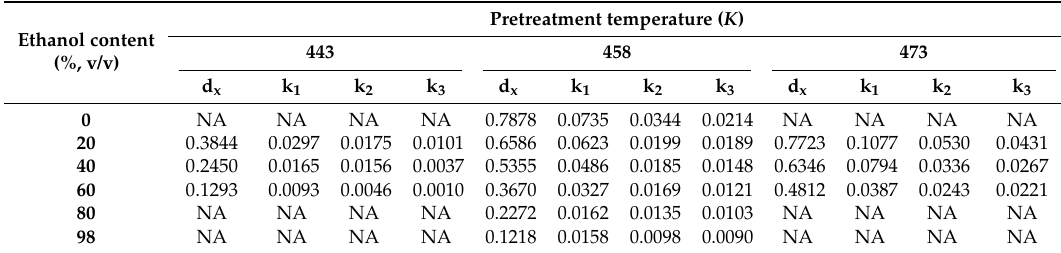
Table 1. The parameters of kinetic models shown in Equations (9), (12) and (14) for xylan dissolutions and degradation during EACO